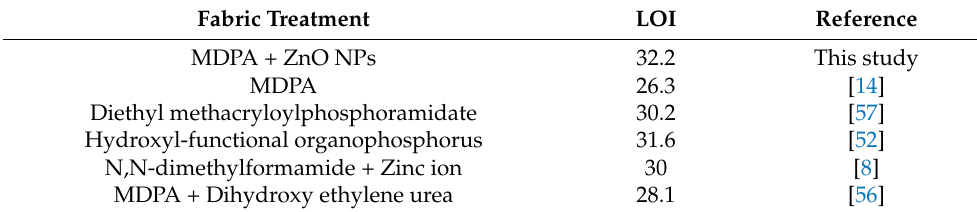
Figure 9. LOI values vs. Zn contents. Table 5. Comparison of LOI.